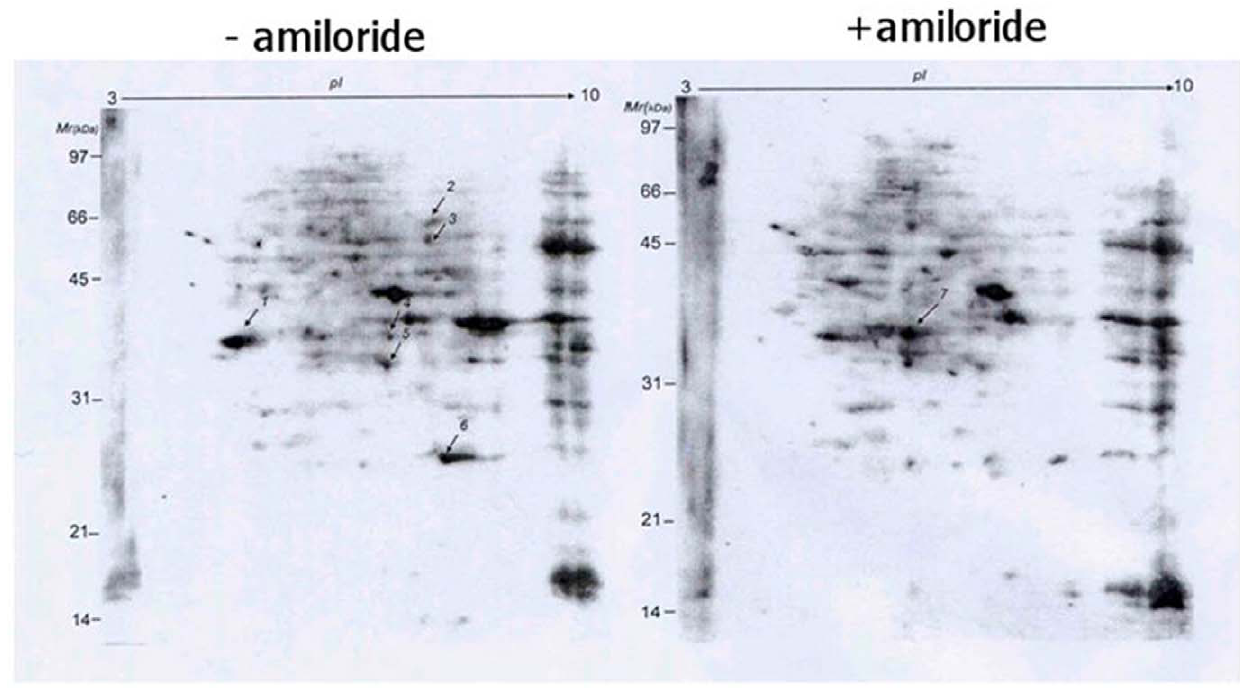
Figure 2. Amiloride effects on cellular phospho-serine proteins. 2D-gel electrophoresis analysis of proteins extracted from Huh-7 cells without (left) and with (right) 0.5mM amiloride treatment for 24 hours showed significant changes for at least ten spots, of which seven (indicated by arrows) were isolated for nano-LC-MS/MS spectrometry analysis and protein identification, as shown in Table 1.